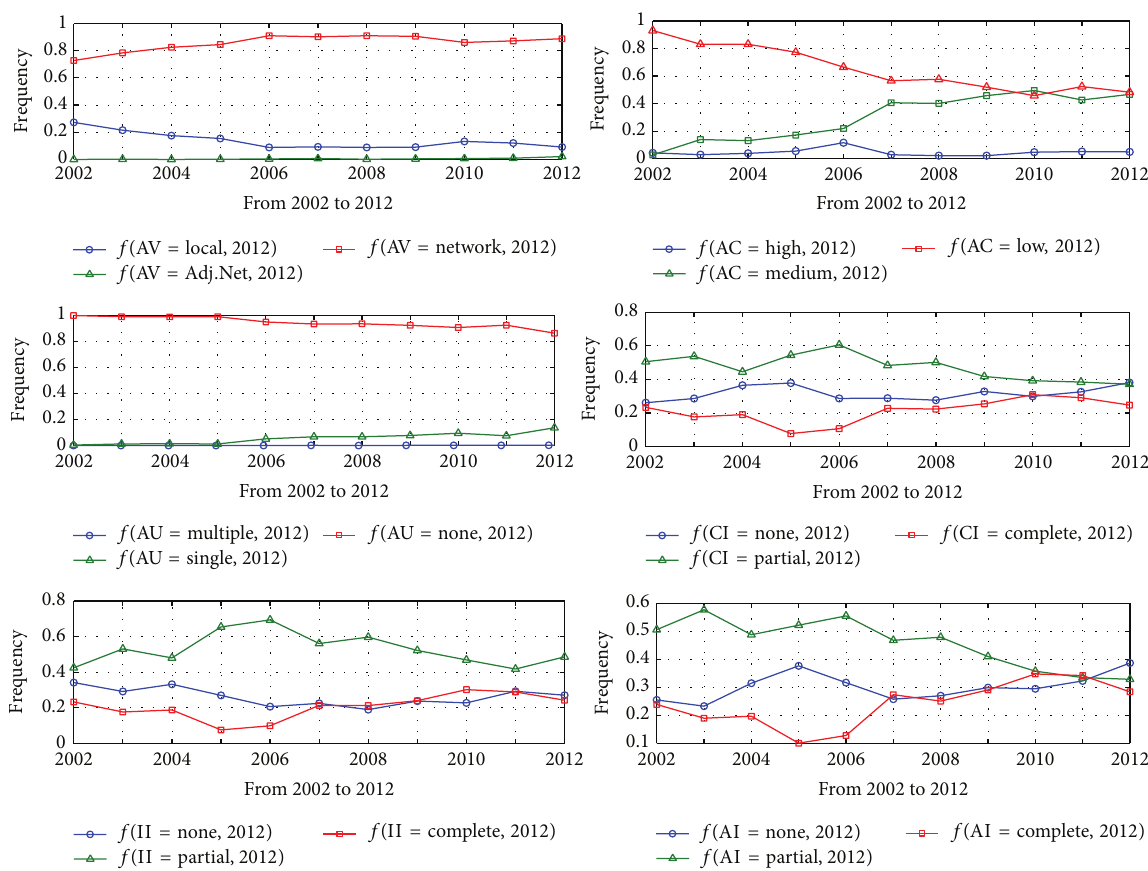
Figure 2: The frequency change curves of the six metrics from 2002 to 2012, where 𝑇 = {2002, 2003, . ..} . As can be seen, the curves of AV, AC, and AU are divergent, while the curves of CI, II, and AI have approximate convergence (to the value 1/3). These curves reflect the probability of the occurrence of the metric values of each